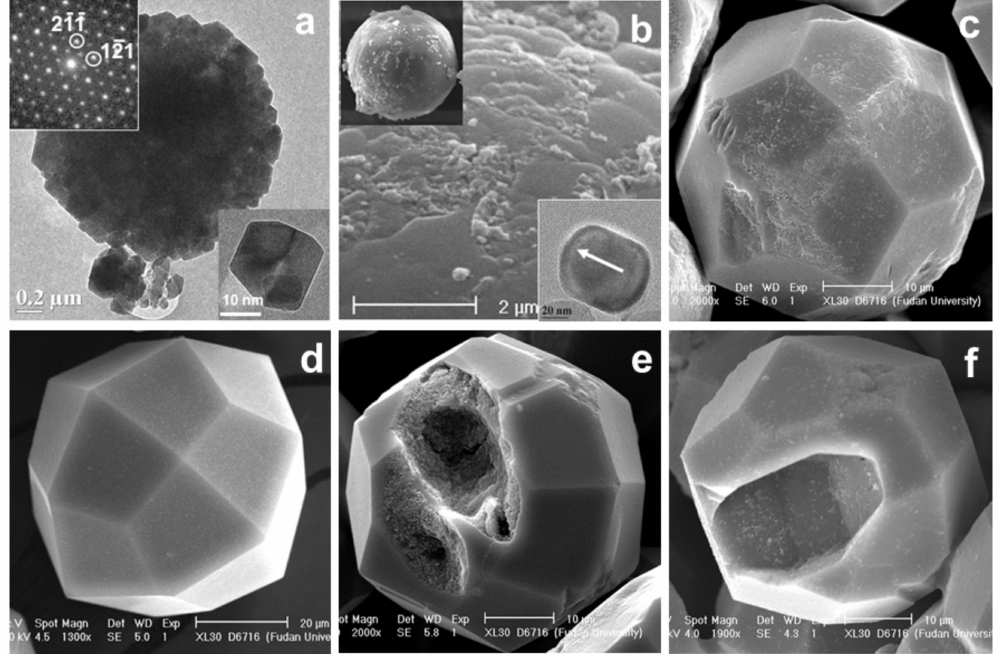
Figure 1. Electron microscopic observation (a, transmission electron microscopy (TEM) and others, scanning electron microscopy (SEM) images) of zeolite analcime particles with different growth times. ( a ) A discus-shaped aggregate of nanoplates after growth for 16 h. Top inset is the corresponding selected area electron diffraction (SAED) pattern and bottom inset shows an individual nanoplate. ( b ) Surface of a polycrystalline microsphere after growth for 20 h. Top inset shows a whole particle and bottom inset is a short nanorod. The arrow indicates the preferred growth direction of the nanoplates along the [111] zone axis. ( c ) A typical particle in 24 h sample. ( d , e ) Icositetrahedral analcime particles with growth time of 8 days. ( f ) A hollow single crystal after growth of 22 days. Reprinted with permission from [11]. Copyright 2007, American Chemical